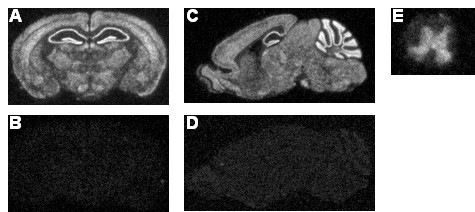
Neuronal ADAM22 mRNA expression in the CNS. To determine the ADAM22 mRNA distribution, in situ hybridisation analysis using 35S-labeled probe was performed. Coronal (A, B) and sagittal (C, D) sections of the mouse brain and spinal cord (E) were shown. Using the antisense probe (A, C), strong signals were obtained, especially in the hippocampus and the cerebellum, while no signals was detected by the sense probe (B, D). In the spinal cord, autoradiograms of ADAM22 mRNA was detected in the grey matter (E).